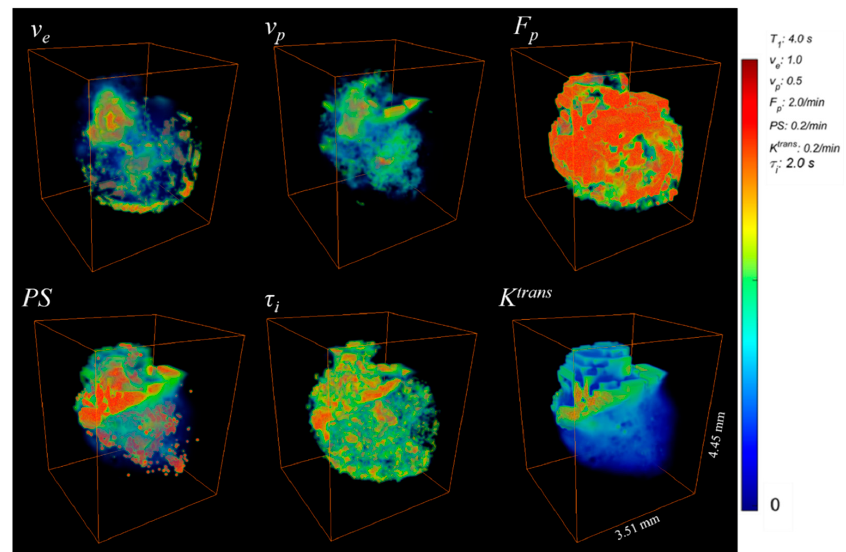
Figure 2. Volume renderings of the 3D contrast kinetic model parameter maps of the whole mouse glioma from Dynamic Contrast-Enhanced MRI data with an isotropic resolution. Included are the 3D maps for extravascular extracellular volume fraction ( v e ), plasma volume fraction ( v p ), blood flow ( F p ), permeability surface area product ( PS ), transfer constant ( K trans ), and intracellular water lifetime ( τ i ).